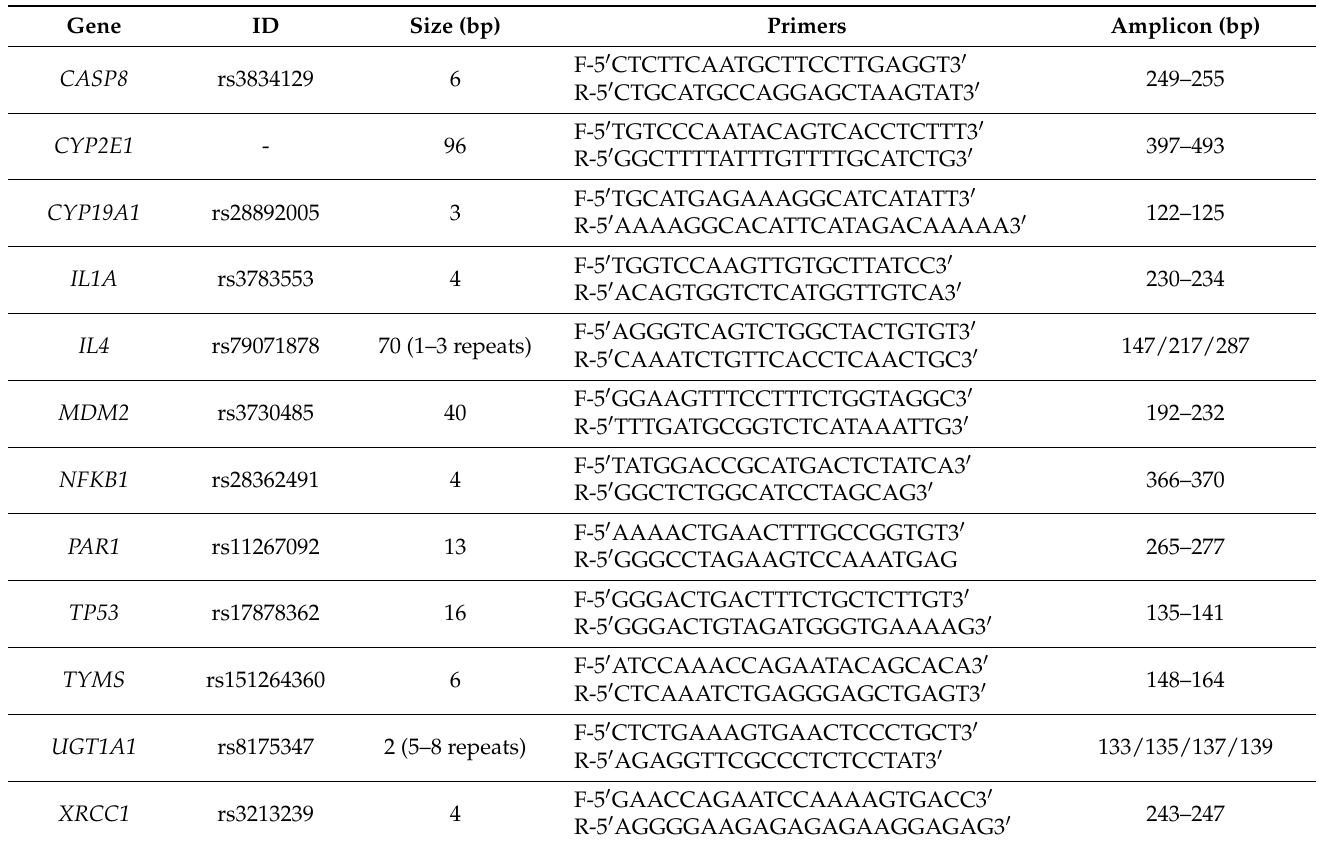
Table 1. Technical characterization of the investigated